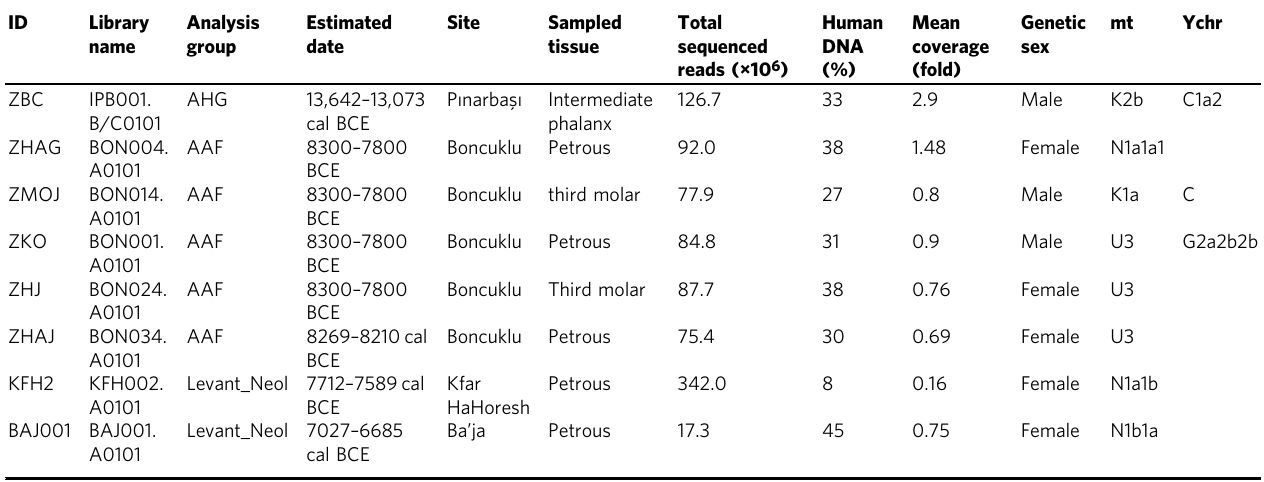
Table 1 An overview of ancient genomes reported in this